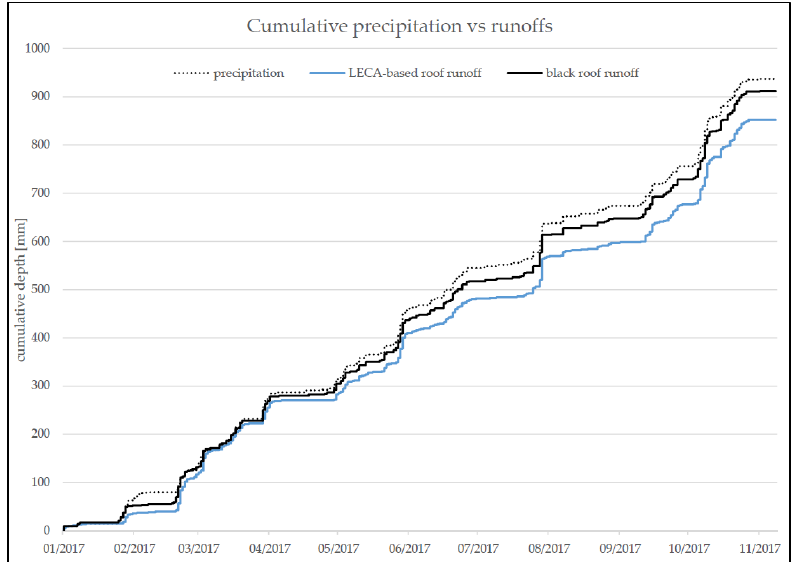
Figure 3. Cumulative hydrograph from the rain gauge and runoffs of the black and the LECA-based roofs.